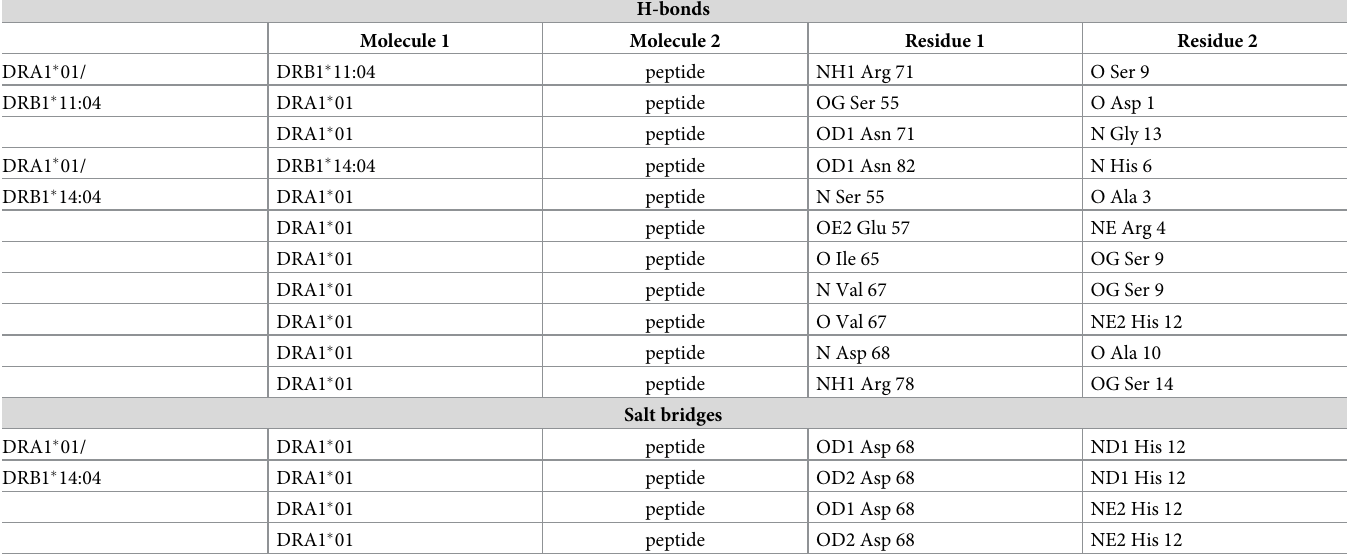
Table 5. The hydrogen bonds and the salt bridges between DRA/DRB chains and the peptide in both structures. Columns ‘Molecule 1’/‘Residue’ 1 list the α or β chain of each DR complex (column ‘Molecule 1’) and the residues that interact with the peptide (column Residue 1). Column ‘Molecule 2’ refers always to the peptide. In column ‘Residue 2’ the peptide’s residues that form H-bonds and salt bridges with any DR-complex amino acid are listed. The atoms involved are